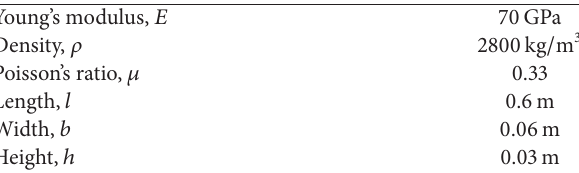
Table 3: Relative errors of force identification.